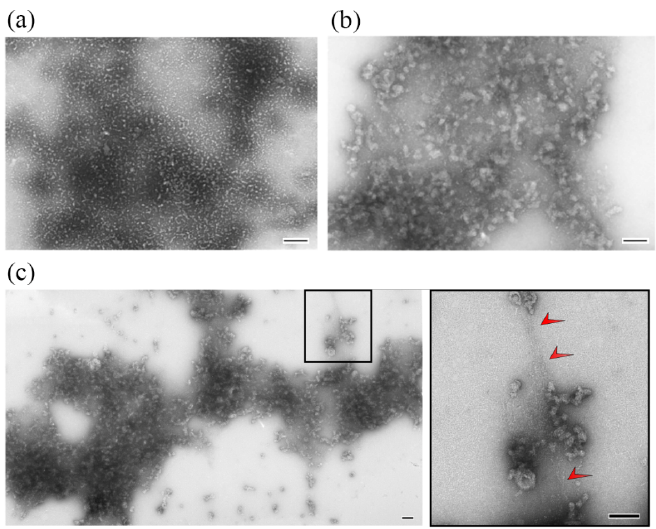
Figure 3. Electron microscopy of SMT HMW aggregates formed in a solution containing 0.15 M glycine–KOH at pH 7.0–7.5 at 4 °C. ( a ) 1 h aggregation of SMT HMW . ( b , c ) 24 h aggregation of SMT HMW . Protein filaments of a diameter of about 4 nm between amorphous aggregates (shown by red arrows on the insert) can be seen. The most representative data, obtained as a result of 10 independent experiments, are given. Scale bar, 100 nm.